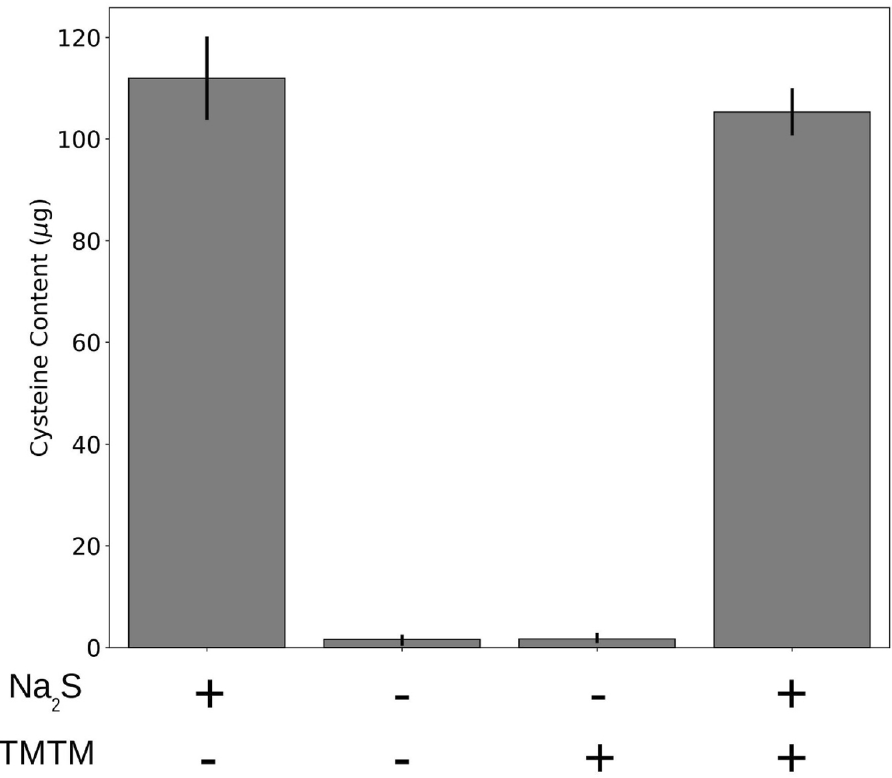
Figure 7. Incorporation of TMTM requires more than OASTLs. Cysteine biosynthesis was monitored in 4 parallel samples. In each sample, either Na 2 S, water, TMTM or both Na 2 S and TMTM was added as substrate for OASTLs. Error bars represent SEs from 3 independent measurement using total protein extract from 3 different biological